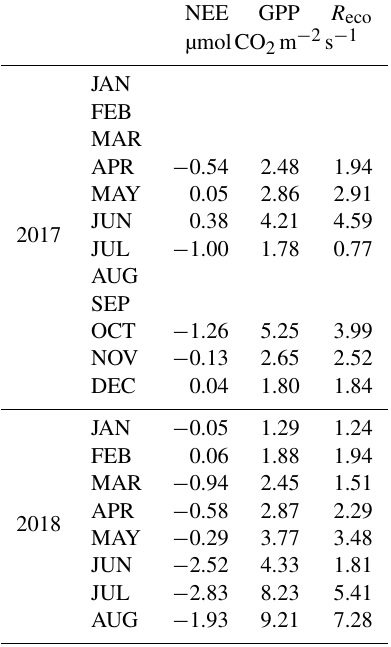
Table 1. Daily average values of the net ecosystem exchange (NEE), gross primary productivity (GPP) and ecosystem respira- tion ( R eco ) in a scrub at the Bernal site. Negative values of NEE indicate photosynthetic